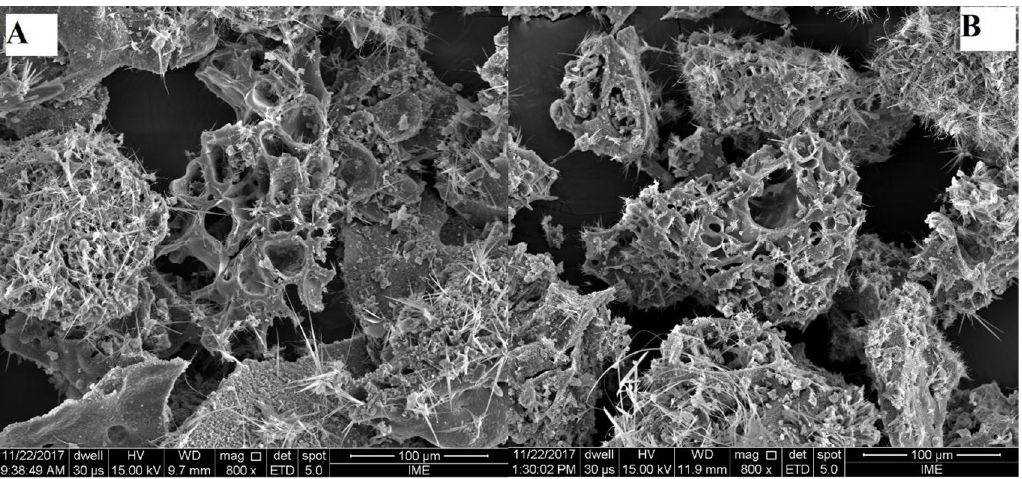
Figure 6. Micrographs of biochar impregnated obtained at 400 °C ( A ) and 450 °C ( B ). Analyzing the results of the SEM image analysis for the in natura charcoals for the test temperatures of 400 ◦ C and 450 ◦ C, image (A) shows a difference in the SEM of